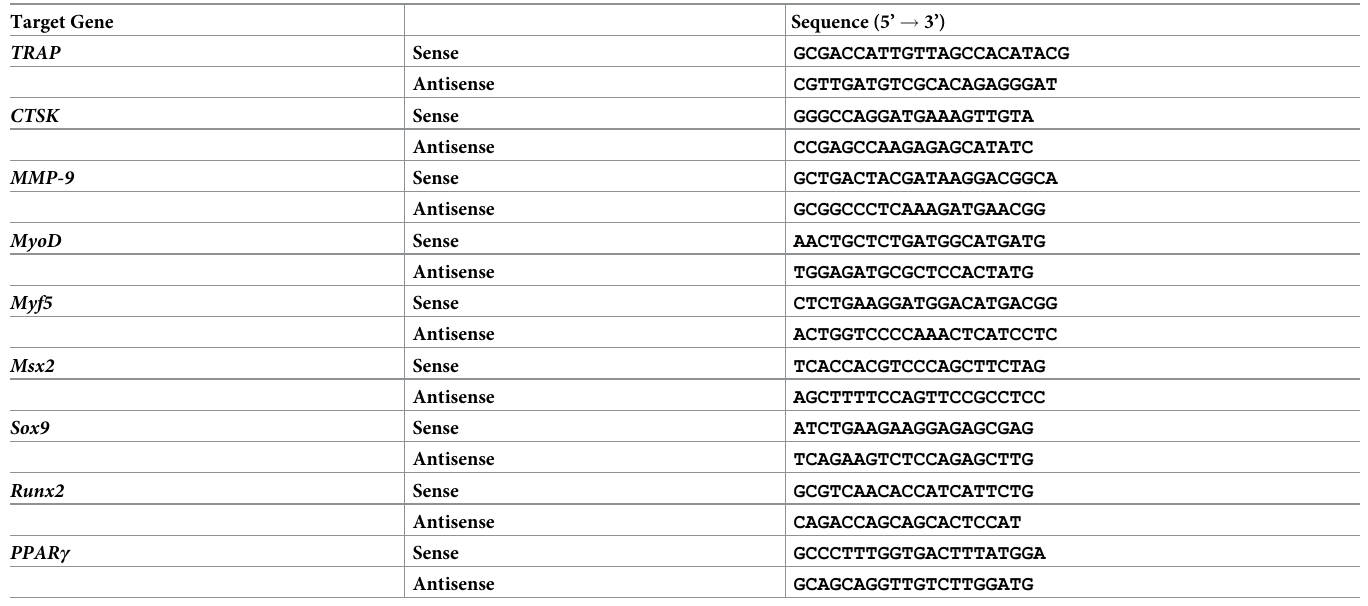
Table 1. Specific primer sets used in this